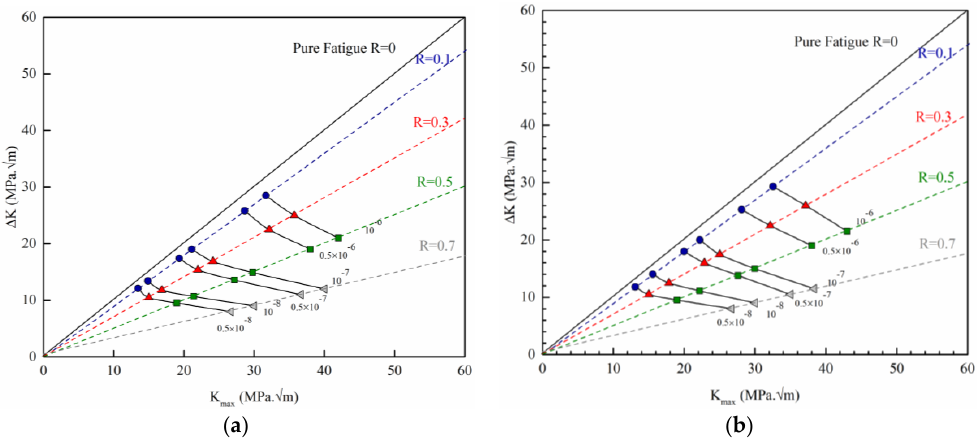
Figure 6. ∆ K – K max plots of ( a ) admixed ( b ) pre-alloyed PM steels, defining two limiting values at different crack growth rates.